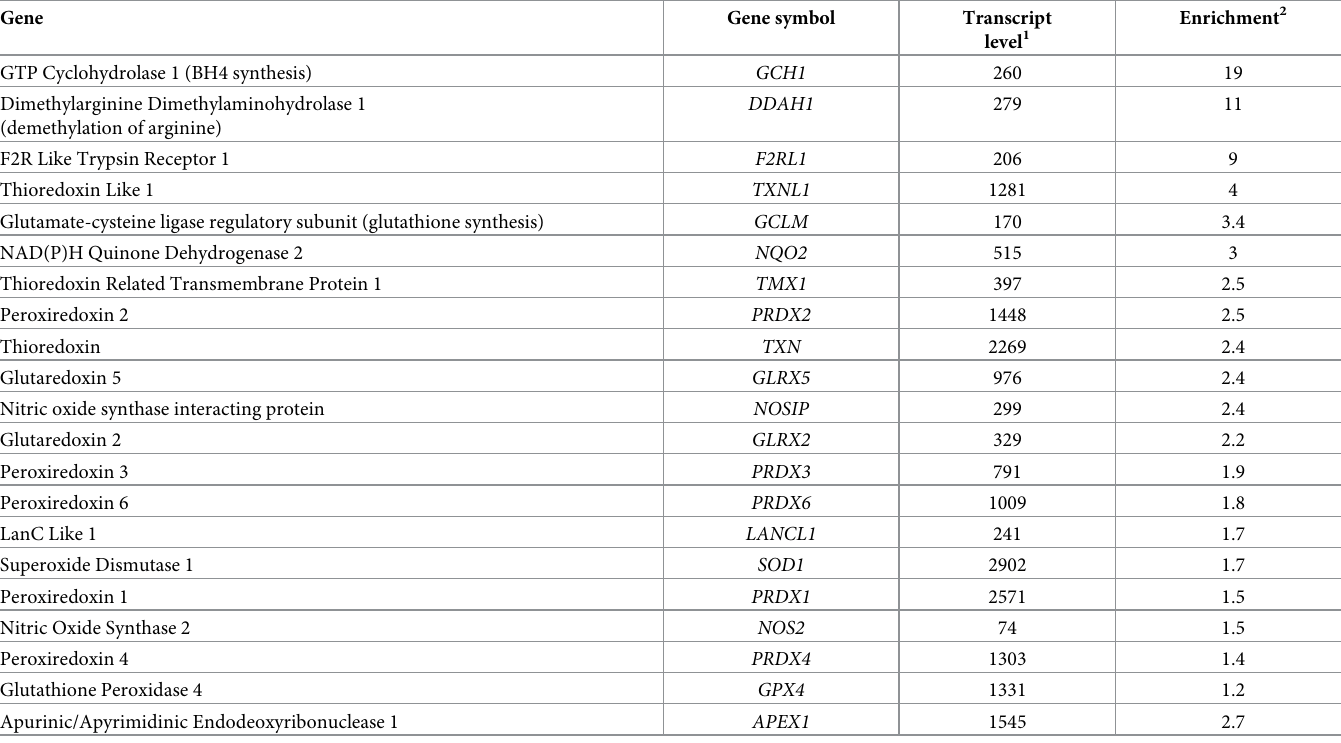
Table 3. Genes with higher expression in HCT116 than in Me45 cells(microarray